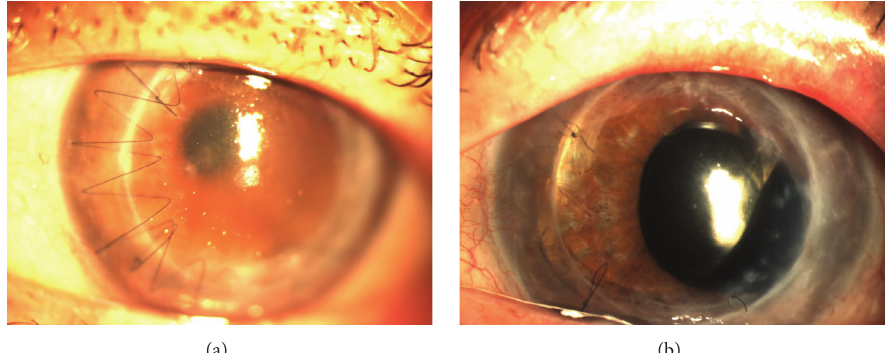
Figure 2: (a) Preoperative photo demonstrating failed PKP with corneal edema. (b) Postoperative photos demonstrating ACIOL with clear cornea and stable DSEK